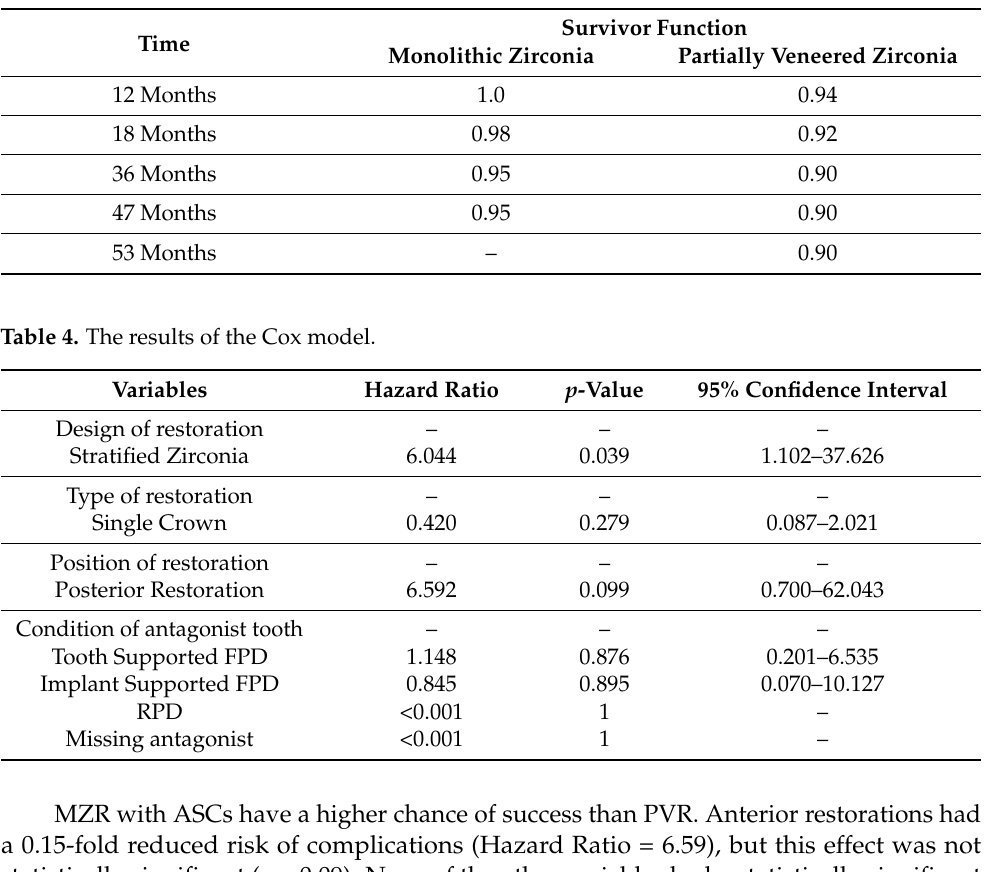
Table 3. Survivor functions at major time points according to the different materials adopted.